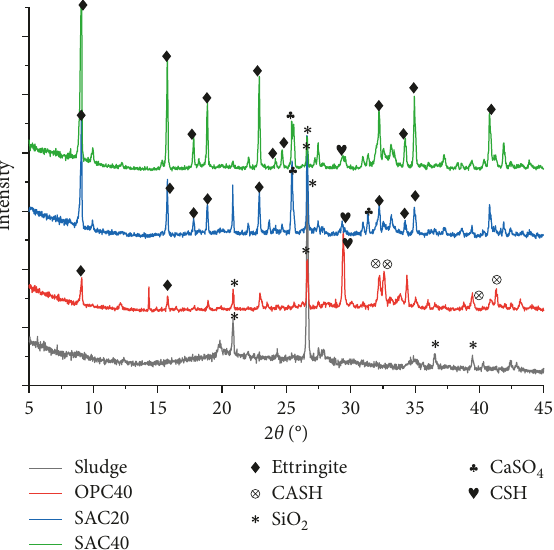
Figure 8: XRD patterns of the solidified samples and sludge.